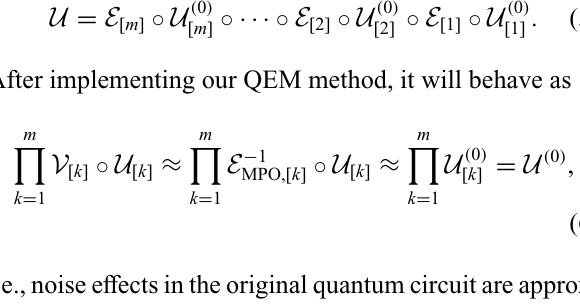
FIG. 1. (a) The schematic diagram of our QEM method based on MPO. We first use a MPO to represent the noisy quantum circuit U E − 1 , which is applied after U to compensate for the error and to restore the MPO . Then we calculate the inverse noise channel MPO ideal circuit U ( 0 ) . (b) Our variational MPO-inverse method. We calculate the inverse of a MPO-represented quantum channel U MPO , with the same bond dimension D . (c) Calculation of the inverse noise channel E − 1 which is parameterized as a MPO U − 1 MPO contraction and truncation methods, whose bond dimension is D (cid:2) . (d) A deep circuit is divided into m parts, each with d 0 layers. One is truncated to D (cid:2) = 1 and simulated by single-qubit gates. may apply our QEM method on each part, where E − 1 MPO,[ k ] U | ρ (cid:5)(cid:5) [42]. One can use a 4 N q × 4 N q matrix to represent a